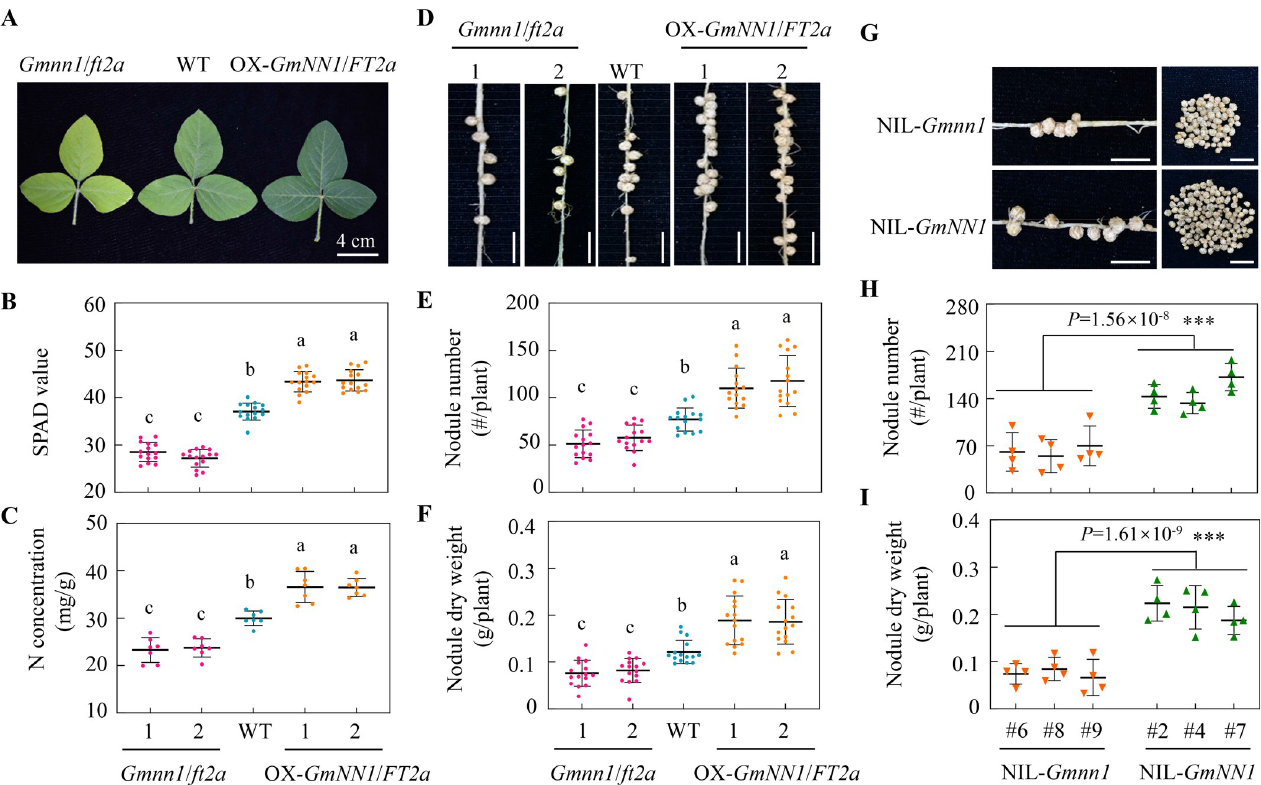
Fig 2. Functions of GmNN1/FT2a in nitrogen nutrition and nodulation. (A ) Pictures of new leaves at 21 dai in loss-of-function mutants of GmNN1/FT2a ( Gmnn1 / ft2a ), WT, and GmNN1/FT2a overexpressing (OX- GmNN1/FT2a ) lines. (B) Leaf SPAD values ( n = 15). (C ) Leaf N concentration ( n = 7). Values are the means from 2 independent experiments. (D ) Phenotype of nodulation. Scale bars, 1 cm. (E ) Nodule number ( n = 15). ( F ) Nodule dry weight per plant ( n = 15). (G) Performance of nodulation at 20 dai between NIL- Gmnn1 and NIL- GmNN1 . Scale bars, 1cm. (H) Nodule number ( n = 4). (I) Nodule dry weight per plant ( n = 4). Three independent lines of each NIL were generated and 4 biological replicates for each line were harvested for nodulation analysis. All data are given as mean ± SD. Different letters denote significant differences ( P < 0.05) according to Duncan’s multiple range comparison tests, and asterisks denote significance of differences (threshold P = 0.05) according to Student t tests; ��� P < 0.001. Data underlying the graphs in the figure can be found in S1 Data. dai, day after inoculation; NIL, near-isogenic line; WT, wild